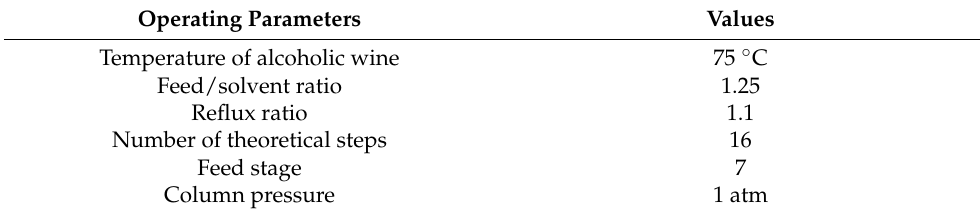
Table 3. Various operating parameters of Distillation Column